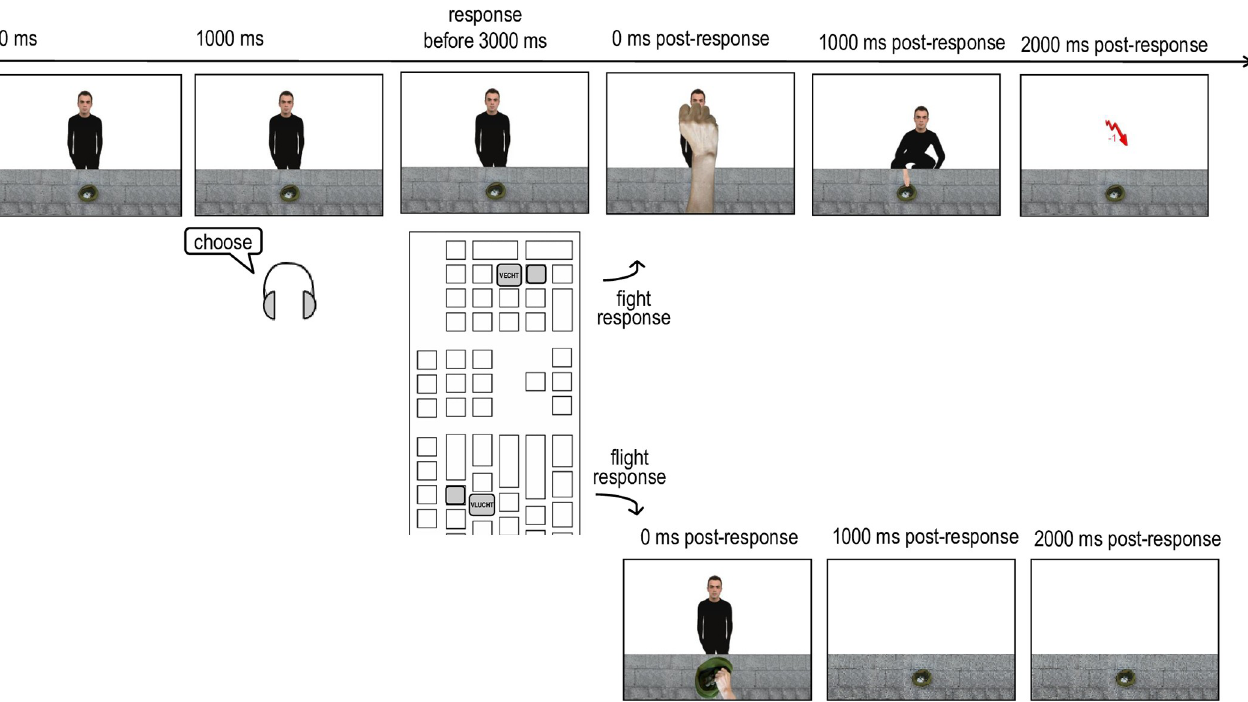
Fig 2. Order of events in a response trial of the test phase in the easy-flee condition with the right-fight-left-flee hand-R mapping. The instruction to choose was presented at 1000 ms post-stimulus onset and participants had to respond before 3000 ms post-stimulus onset. A fight response was followed by a fist punching the avatar, but the avatar nevertheless crouched and stole the money at 2000 ms post-stimulus onset. A flee response was followed by a hand grabbing the